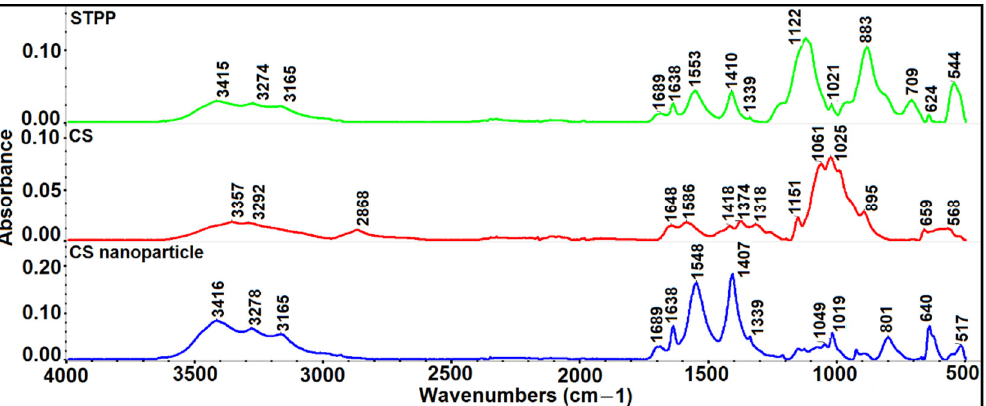
Figure 4. ATR-FTIR spectra of chitosan (CS), sodium tripolyphosphate (STPP), and CS nanoparticles (CSNPs).